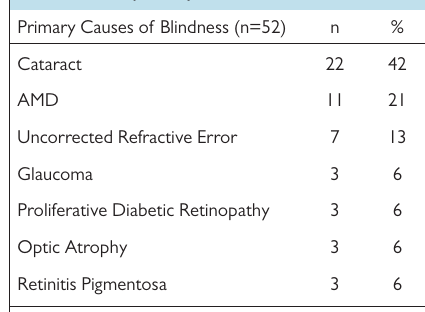
Table 3. The primary causes of